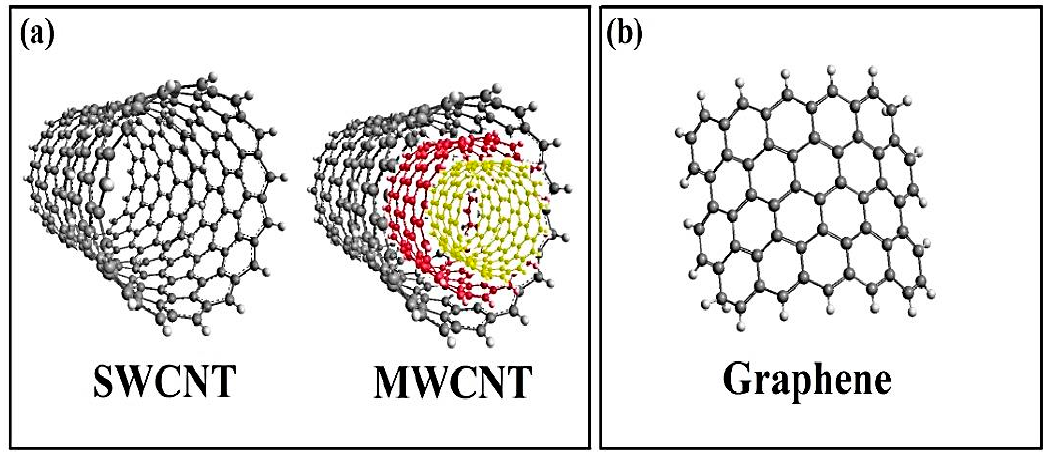
Figure 4. Schematic figure of the morphological structure of: ( a ) CNTs and ( b ) single-layer graphene sheet [58].